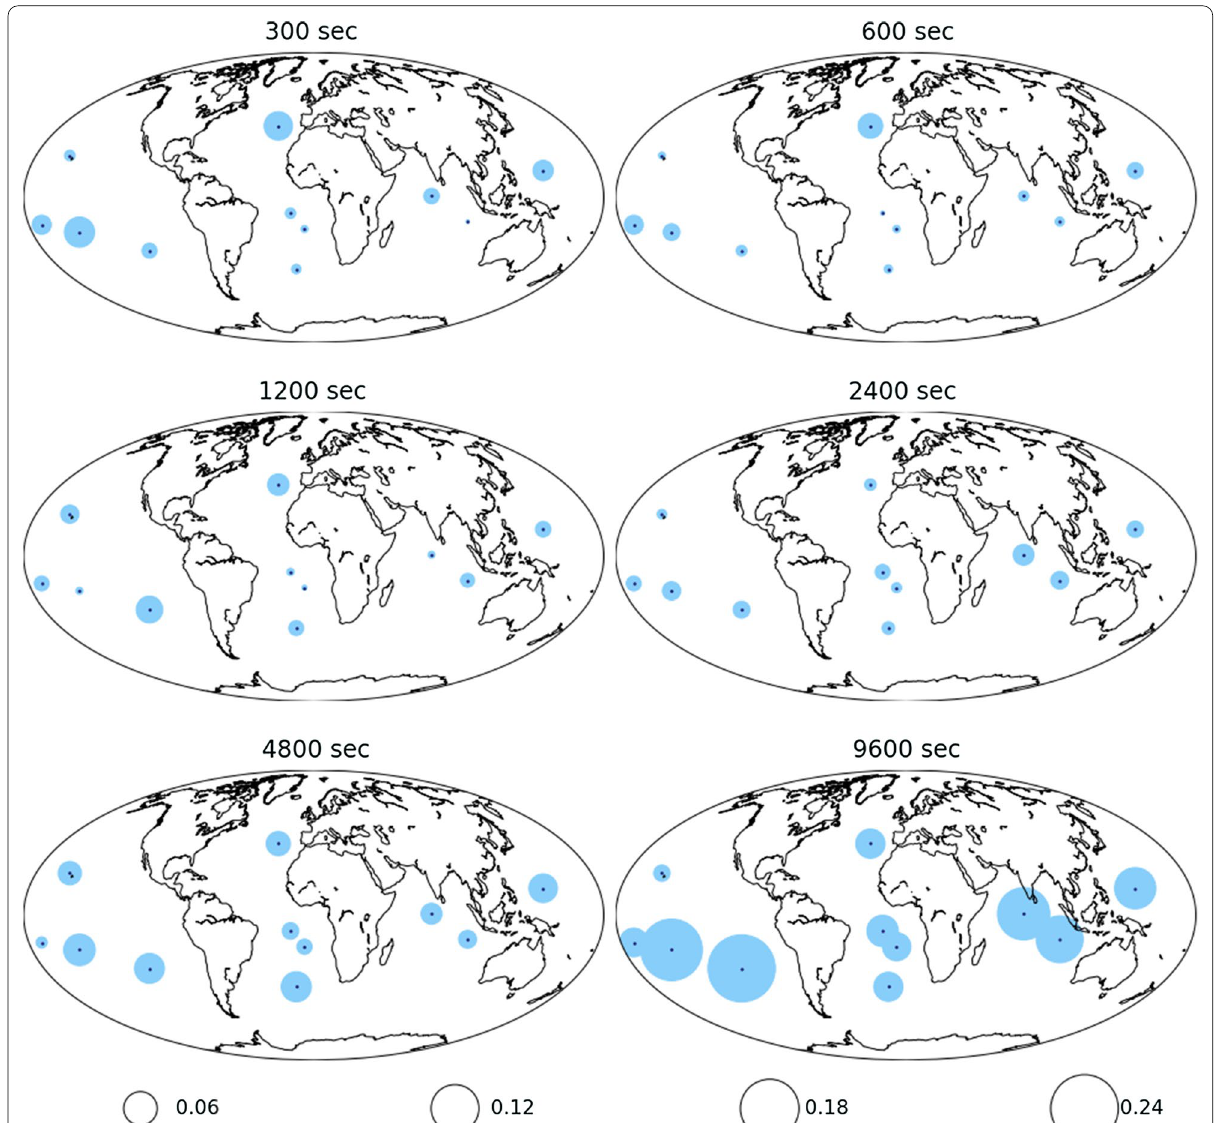
Fig. 18 Difference between “December” and “June” T zy at island observatories, shown as filled circles. “Experimental” and “modeled” differences are colored by light and dark blue, respectively. The size of circles below the plots indicates four ranges of